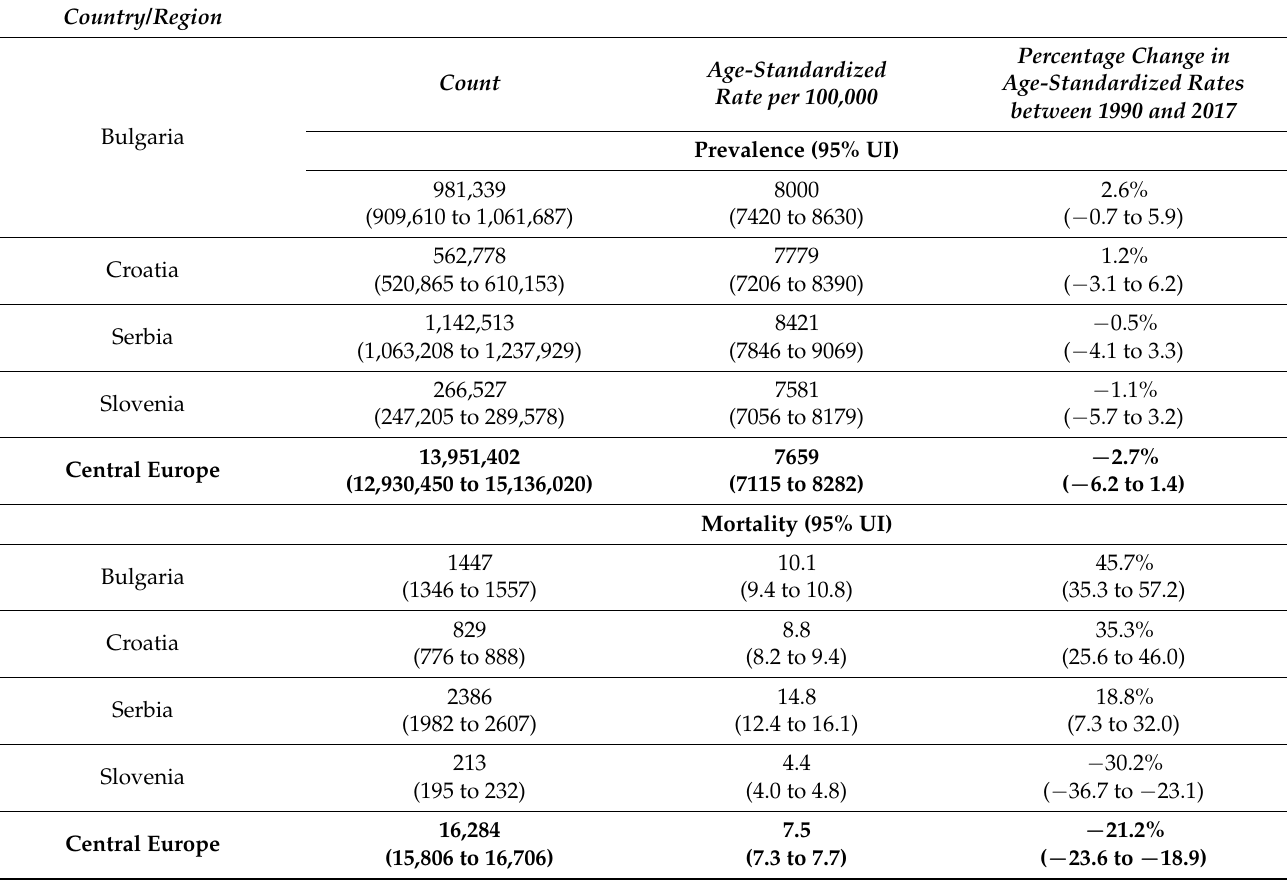
Table 1. CKD prevalence and CKD-related mortality rates in the four countries of the Balkan region, as of